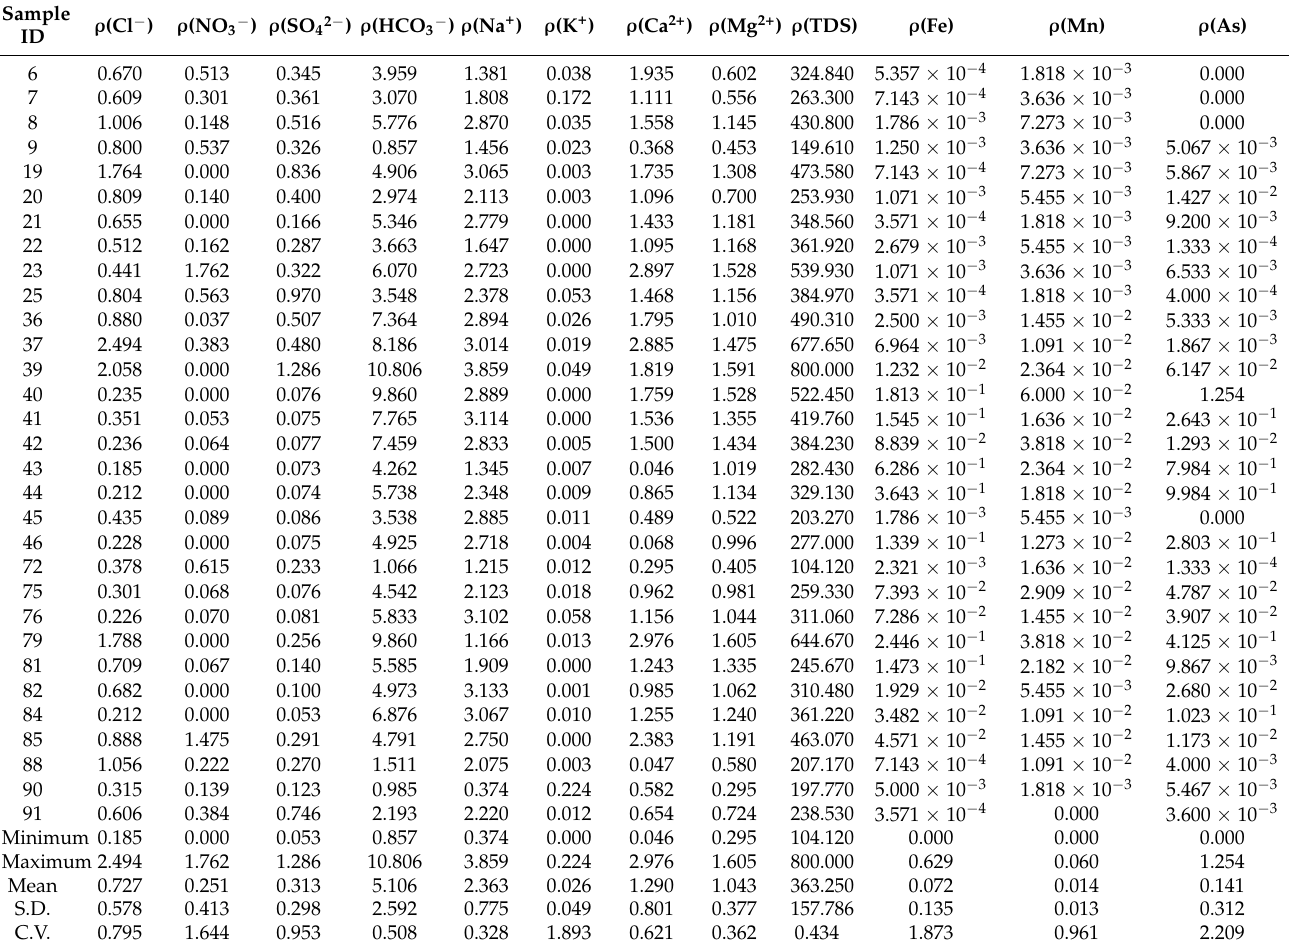
Table 2. Statistical characteristics of the chemical composition of confined